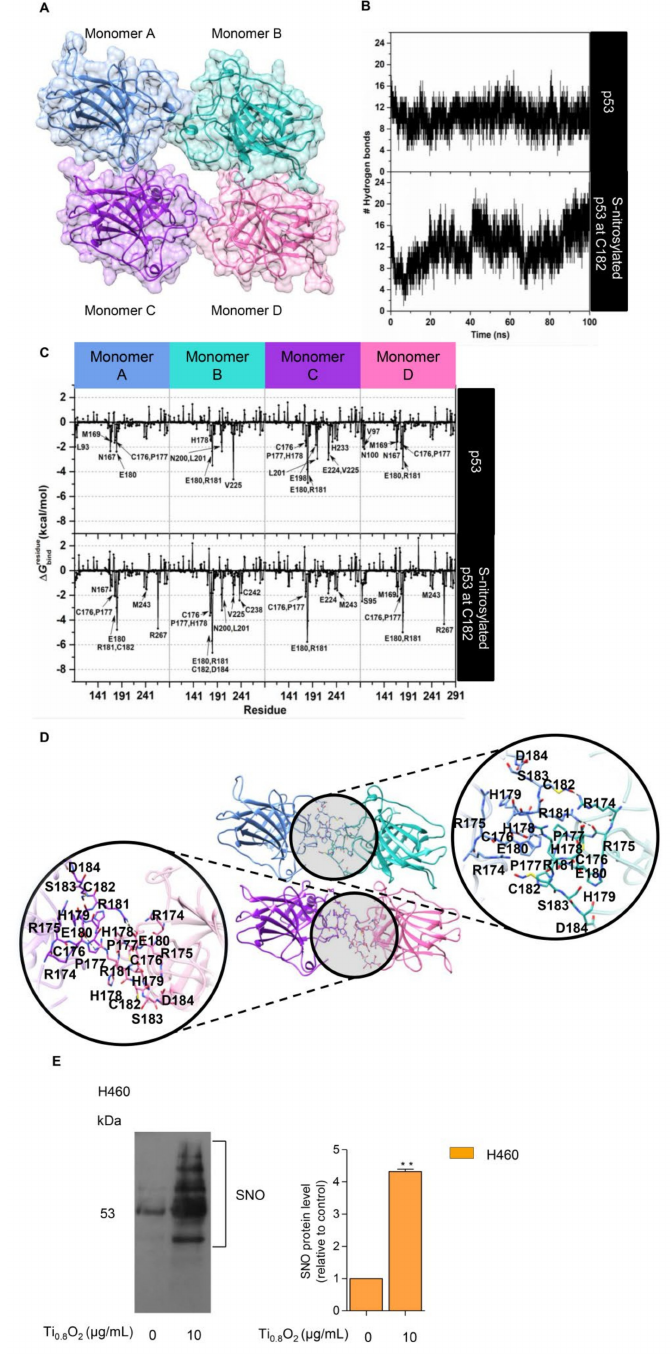
Figure 9. S -nitrosylation in the regulation of p53 stability. ( A ) Three-dimensional (3D) structure of the tetrameric p53 core domain without DNA bound (PDB ID: 3KMD); ( B ) time evolution of the total number of intermolecular hydrogen bonds formed between each monomer of the p53 core domain and its adjacent monomer; ( C ) the plot of (kcal/mol) of the p53 tetramer for the native form (top) and the C182 S -nitrosylation (bottom) system; ( D ) the representative 3D structure taken from the last MD snapshot of the S -nitrosylation system, with hydrogen bonds and electrostatic interactions represented by black dashed lines; ( E ) S -nitrosylated proteins determined by Pierce S -nitrosylation Western blot assay. Relative-to-control protein levels are reported ( n = 3). ** p < 0.01 compared with the untreated control at the same